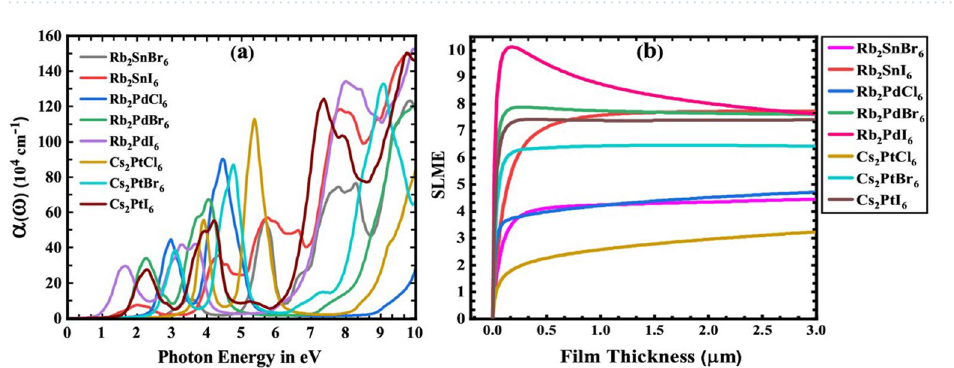
Figure 6. ( a ) Calculated absorption coefficient and ( b ) SLME for A 2 BX 6 (A = Rb, Cs; B = Sn, Pd, Pt; X = Cl, Br, I)